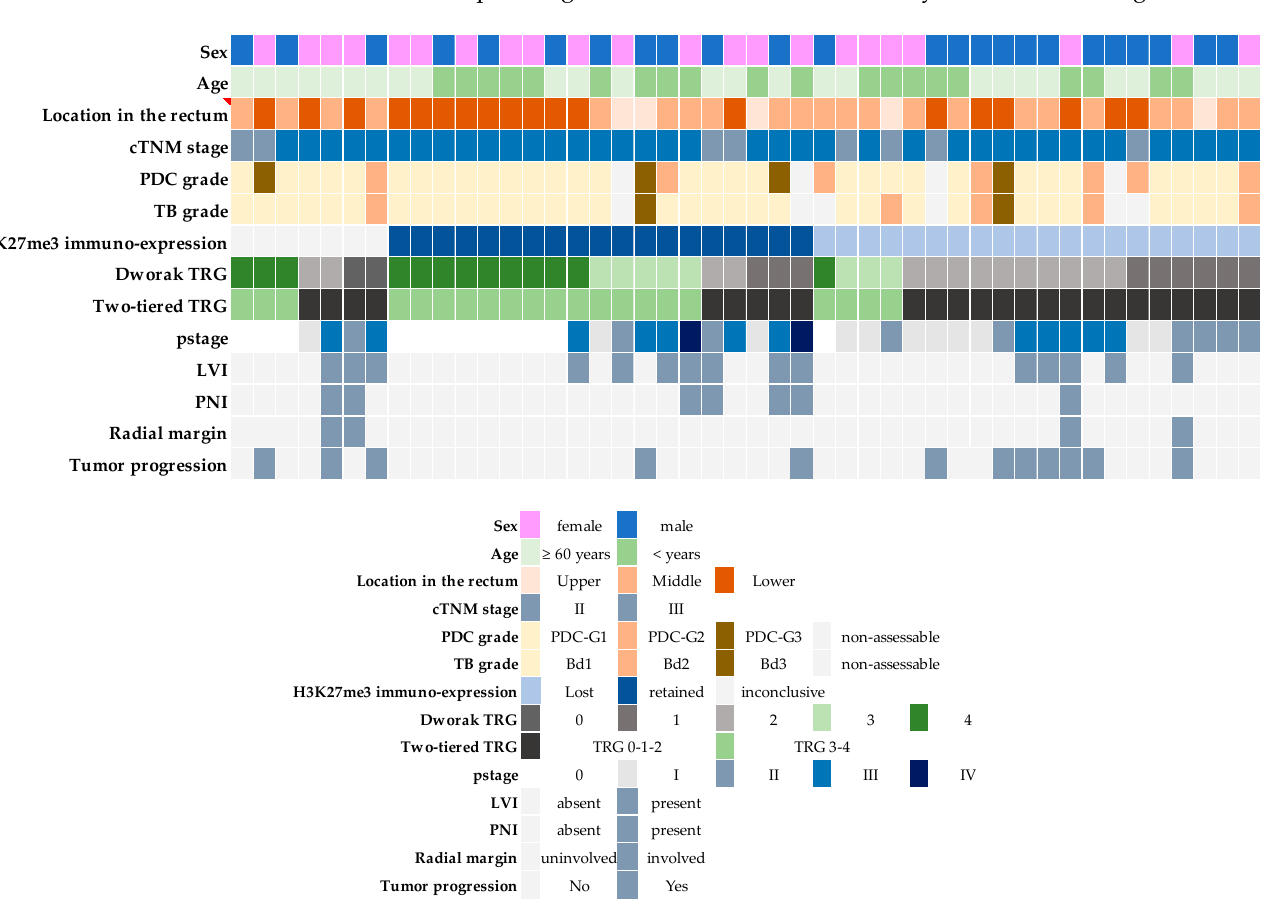
Figure 1. Clinical–pathological features of 46 rectal carcinomas treated with neo-adjuvant chemoradiotherapy and surgery. The loss of H3K27me3 immuno-expression in the pre-treatment endoscopic biopsy was significantly associated with lower Dworak tumor regression grade (TRG). PDC: poorly differentiated clusters. TB: tumor budding. LVI: lympho-vascular invasion. PNI: peri-neural invasion.